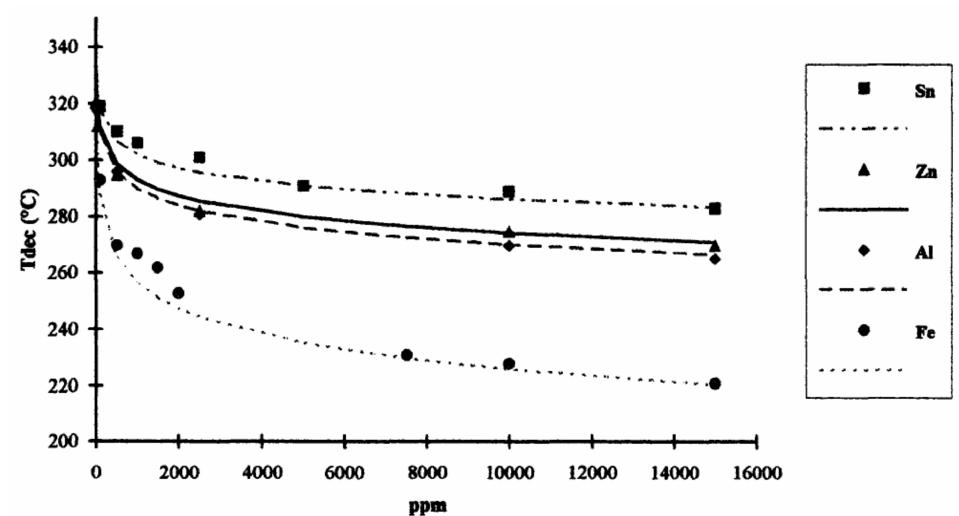
Figure 7. Effect of residual catalyst presence on PLA thermal degradation [147]. Reproduced with permission from Elsevier,